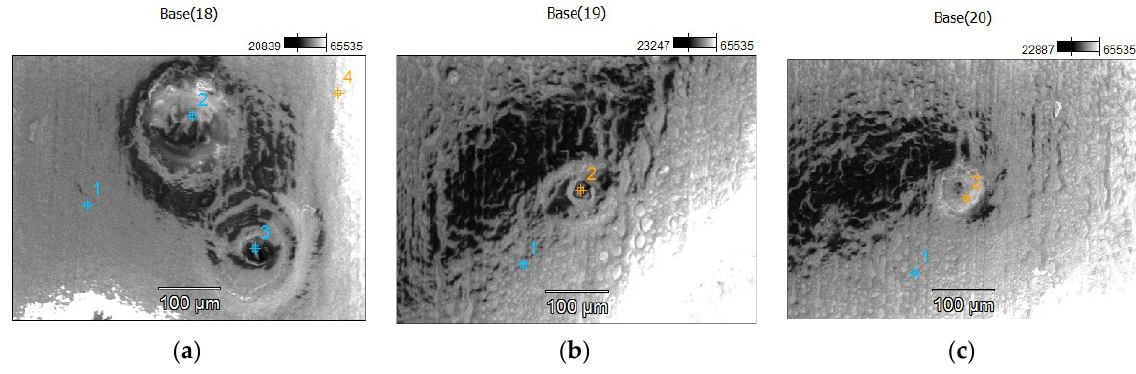
Figure 9. Choosing the analyzed EDX points (1, 2, 3 or 4) in three different zone with defects of the part: ( a ) EDX points in Base(18) area; ( b ) EDX points in Base(19) area; ( c ) EDX points in Base(20) area. Table 3. EDX results for the first area from Figure